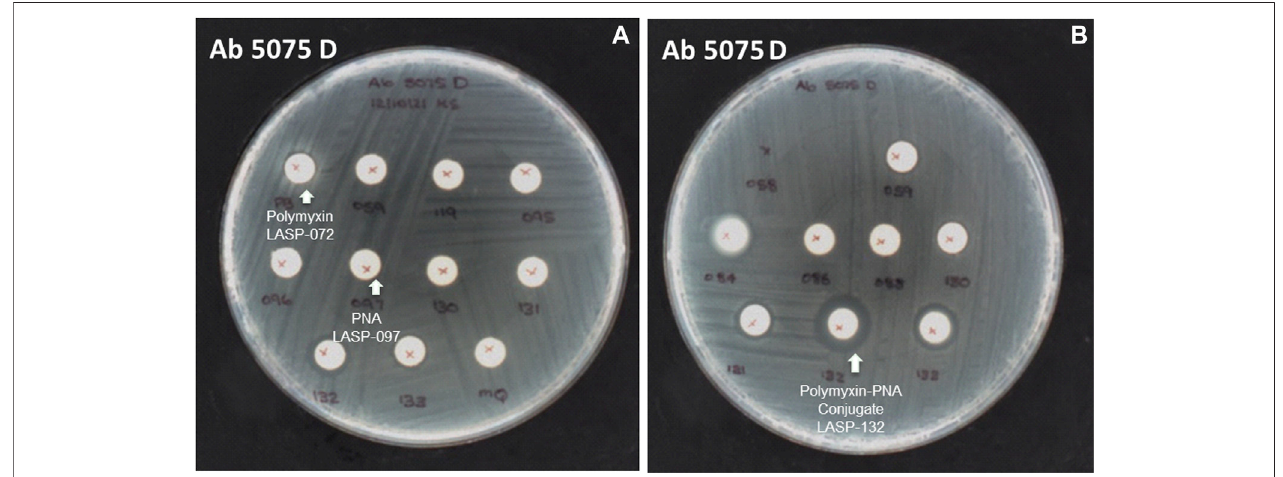
FIGURE 4 | The inhibition zone of peptides, PNA, and peptide-PNA conjugates against A. baumannii 5075D (A) polymyxin and PNA No zones of inhibition observed, (B) polymyxin-acpP PNA conjugate zone of inhibition observed.